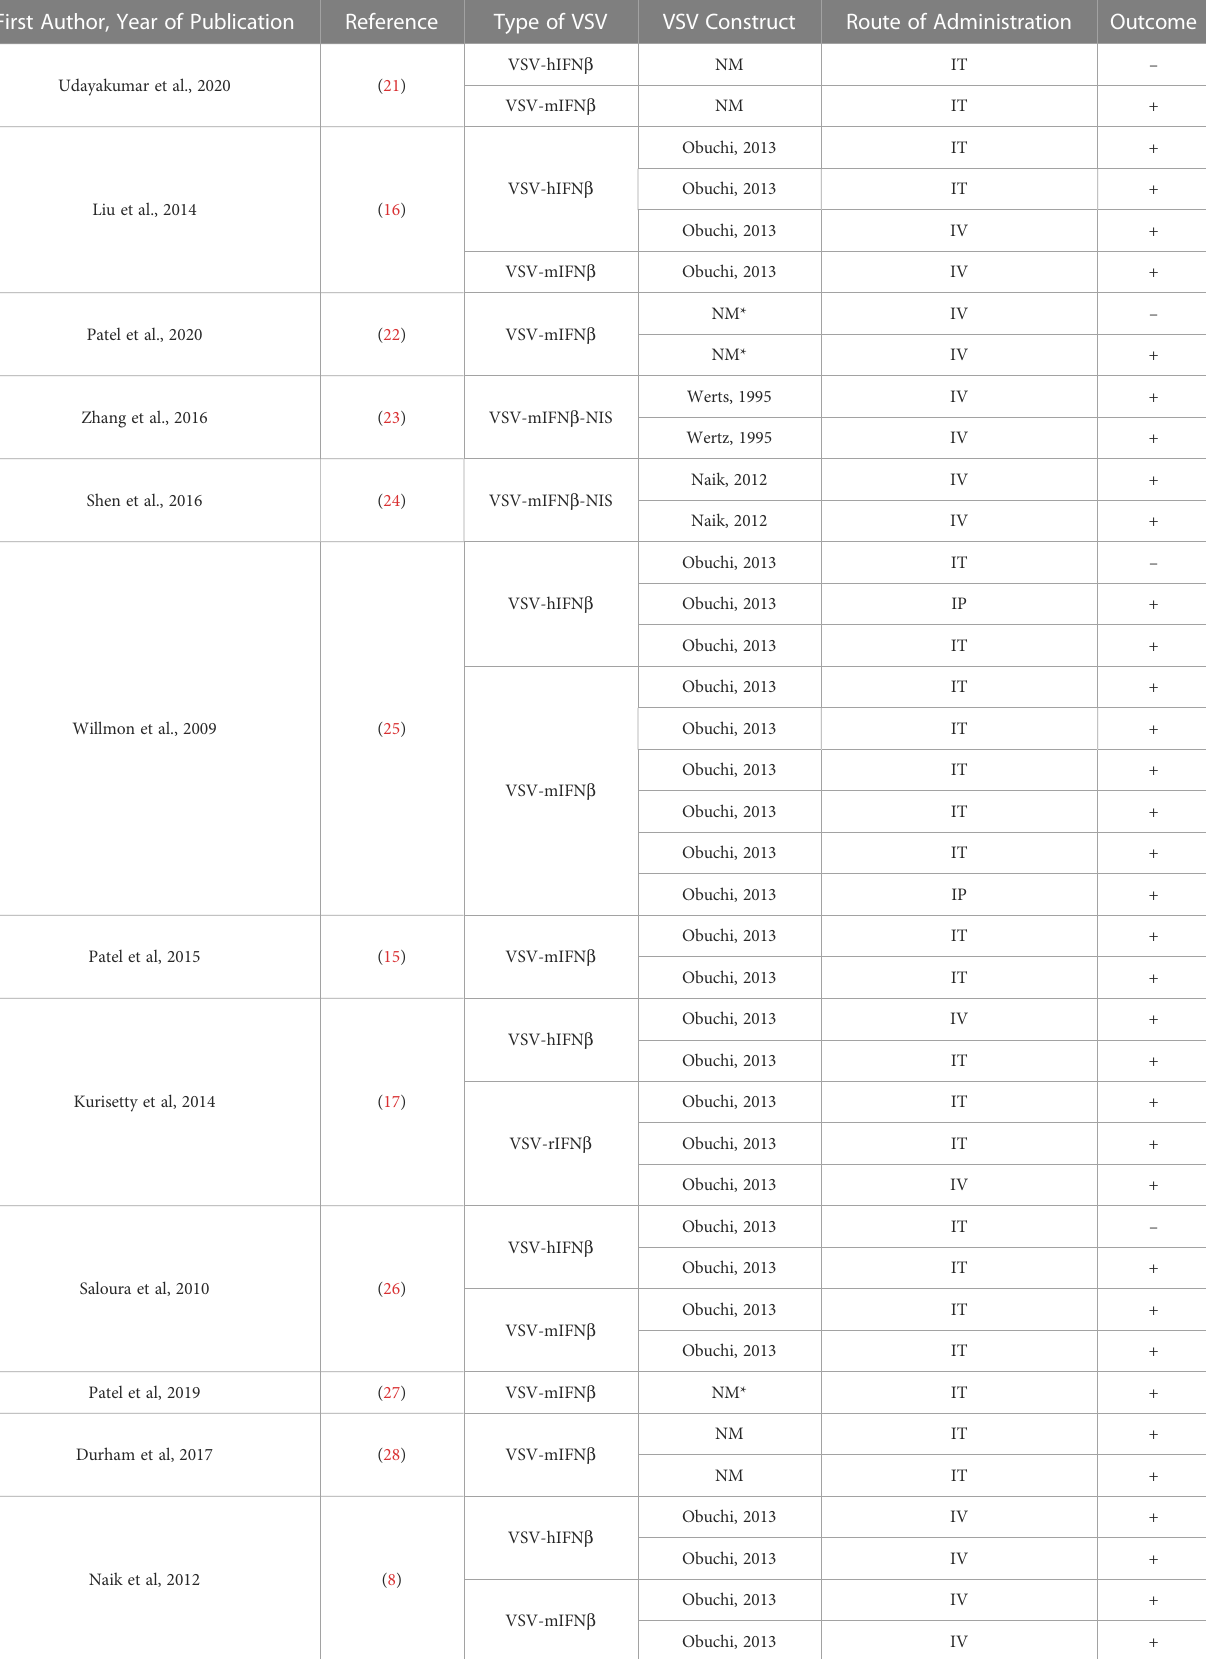
TABLE 5 Summary of the VSV constructs of the reviewed